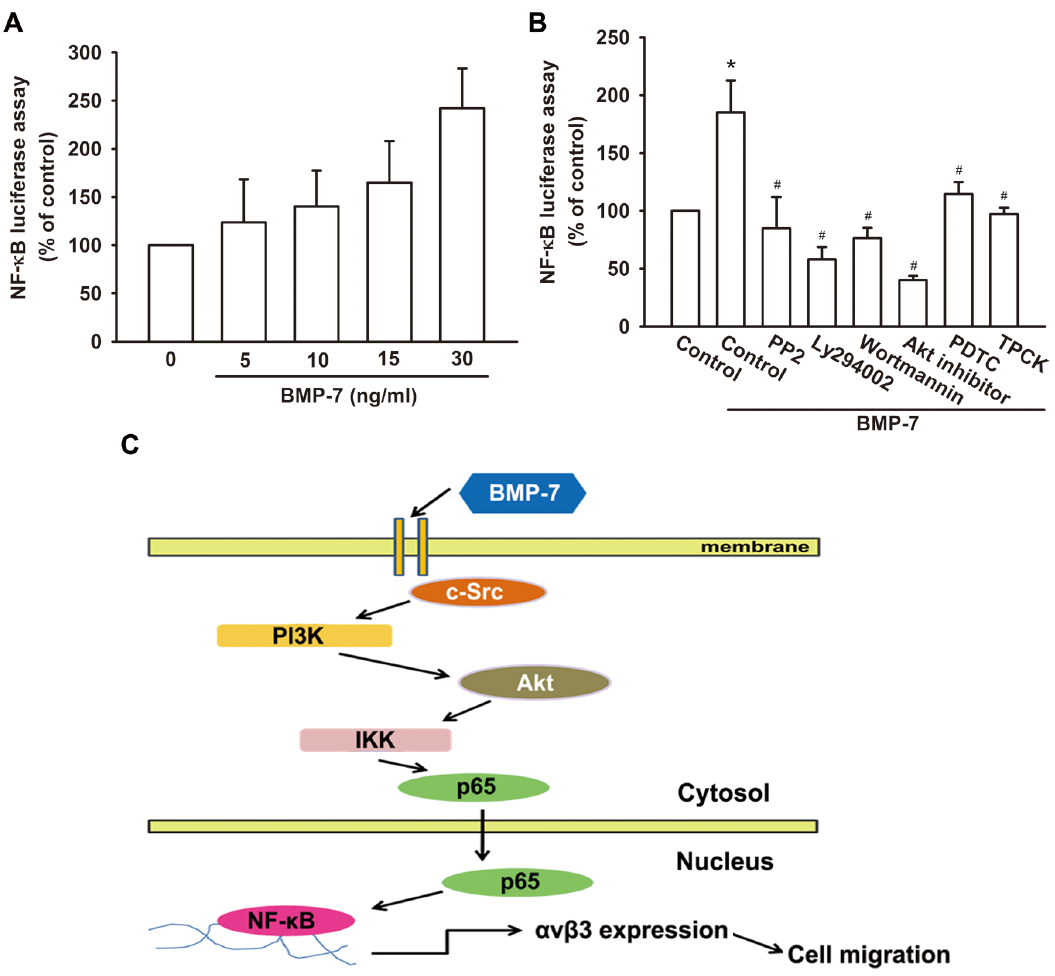
Figure S1 BMP-7 induced cell migration and